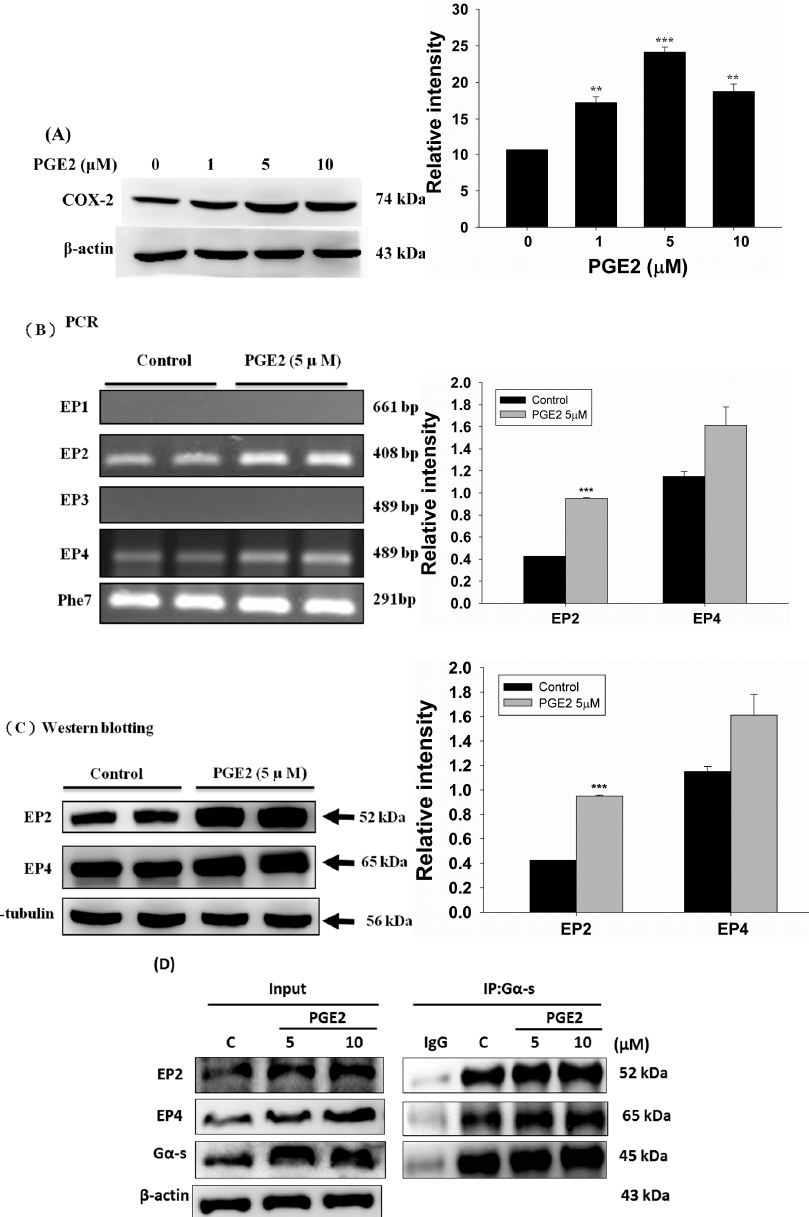
Figure 1. Prostaglandin E2 (PGE2) induces protein expression of COX-2 through EP2 and EP4 in LoVo cells. ( A ) LoVo cells were treated with increasing concentrations of PGE2 (0, 1, 5 and 10 μ M) for 6 h, and cells were then harvested and lysed. Cell extracts were separated by 12% sodium dodecyl sulfate polyacrylamide gel electrophoresis (SDS-PAGE), transferred to polyvinylidene difluoride (PVDF) membranes, and immunoblotted with an antibody against COX-2. ( B ) LoVo cells were treated with 5 μ M PGE2 for 6 h. The expression of EP1–4 in LoVo cells was detected by reverse-transcription PCR. ( C ) LoVo cells were treated with 5 μ M PGE2 for 6 h. Cells were harvested and analyzed for expression of EP2 and EP4 by immunoblot. ( D ) LoVo cells were pretreated with PGE2 (5 or 10 μ M) for 6 h and then harvested for immunoblot analysis using antibodies against G α -s, EP2 and EP4. A co-immunoprecipitation assay was used to determine the degree of association of G α -s with EP2 or EP4. An antibody against G α -s was used for the immunoprecipitation, while antibodies against G α -s, EP2 and EP4 were used for the immunoblot analysis. ** p < 0.01, *** p < 0.001 denotes significant differences from control values. The results were presented as the mean ± standard deviation (SD) of three difference experiments.